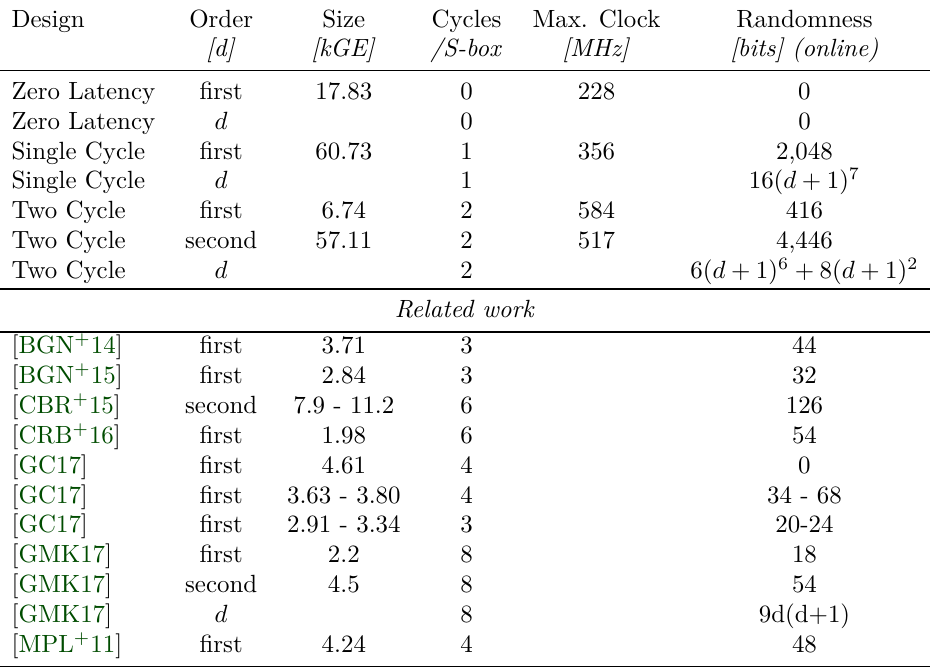
Table 2: Results and comparison of masked AES S-box implementations